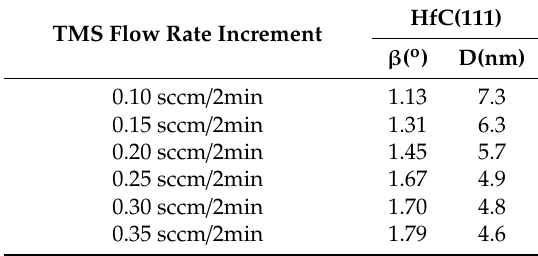
Table 1. The β -D parameters of hafnium carbide (HfC) (111) plane di ff raction vs. di ff erent tetramethylsiline (TMS) flow rate